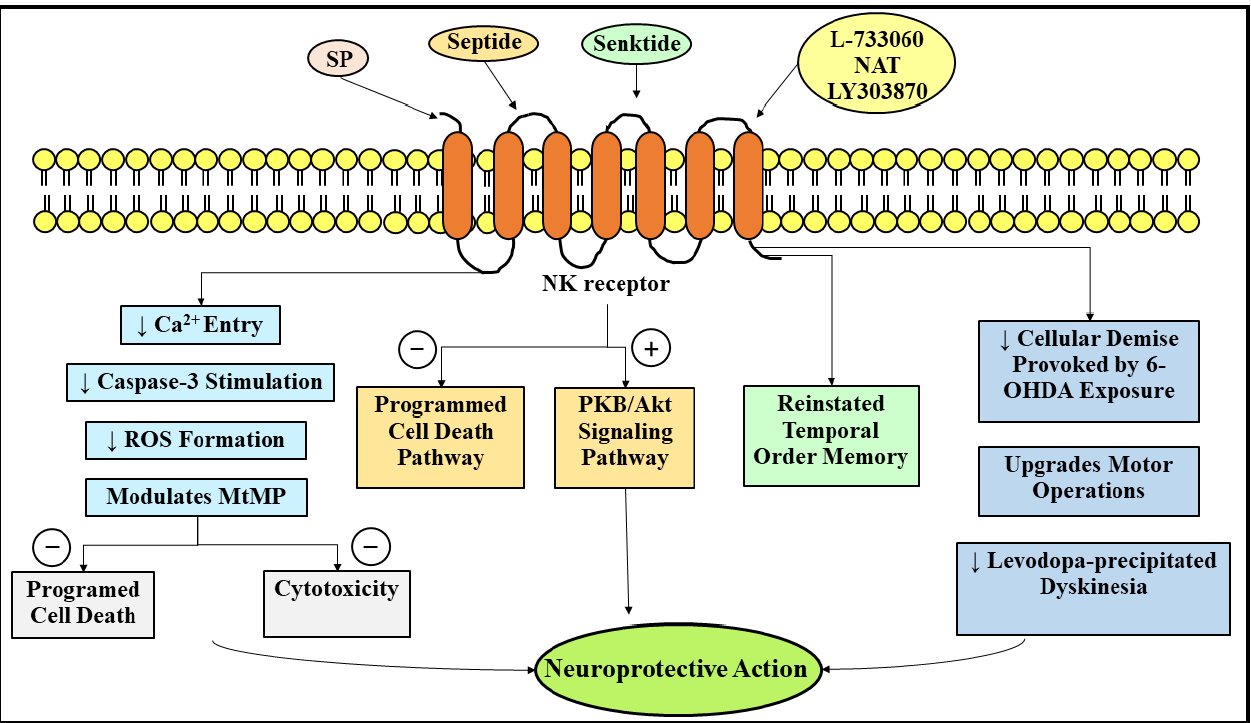
Figure 4. Highlighting the neuroprotective role of Substance P in Parkinson’s disease. SP upon interaction with NK1 receptor, decreases Ca 2+ entry, caspase-3 stimulation, ROS formation, and modulates MtMP, which in turn inhibit programmed cell death and cytotoxicity, and thereby protects MES23.5 cells from MPP + -prompted neurotoxicity. Septide, an analog of SP, upon interaction with NK1 receptor culminates in the suppression of programmed cell death pathways and stimulation of PKB/Akt signaling pathway, thereby protects nerve cells against 6-OHDA-prompted neurotoxicity. Further, senktide, upon interaction with NK3 receptor, reinstated the temporal order memory in the 6-OHDA-lesioned hemiparkinsonian rat model. In addition, the three NK1 receptor antagonists, namely NAT, L-733060, and LY303870, upon introduction, decrease cellular demise provoked by 6- OHDA subjection, upgrade motor operations, and decrease levodopa-precipitated dyskinesia. Finally, by virtue of these mechanisms, SP markedly contributes to neuroprotective action in PD. Subtraction symbol indicates inhibitory/suppressing action, while addition symbol indicates stimulatory action. SP, Substance P; NAT, N-acetyl-L-tryptophan; LY303870, lanepitant; NK, neurokinin; NK1, neurokinin 1; NK3, neurokinin 3; Ca 2+ , calcium ions; ROS, reactive oxygen species; MtMP, mitochondrial membrane potential; MES23.5, DArgic nerve cell line; MPP + , 1-methyl-4-phenylpyridinium ion; PKB/Akt, protein kinase B signaling pathway; 6-OHDA, 6-hydroxy DA; PD, Parkinson’s disease; ↓ , decreasing or